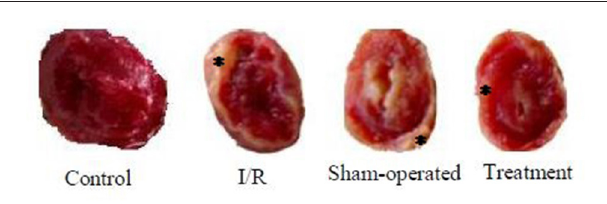
FIGURE 4 | The representative images of the infarct size data were taken from control, I/R, sham-operated, and treatment groups. * denotes the myocardial scar. I/R,